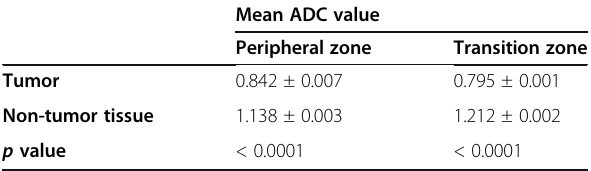
Table 3 Mean ADC value